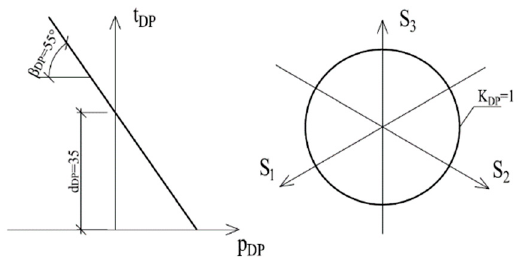
Figure 12. Material model with parameters for the adhesive.